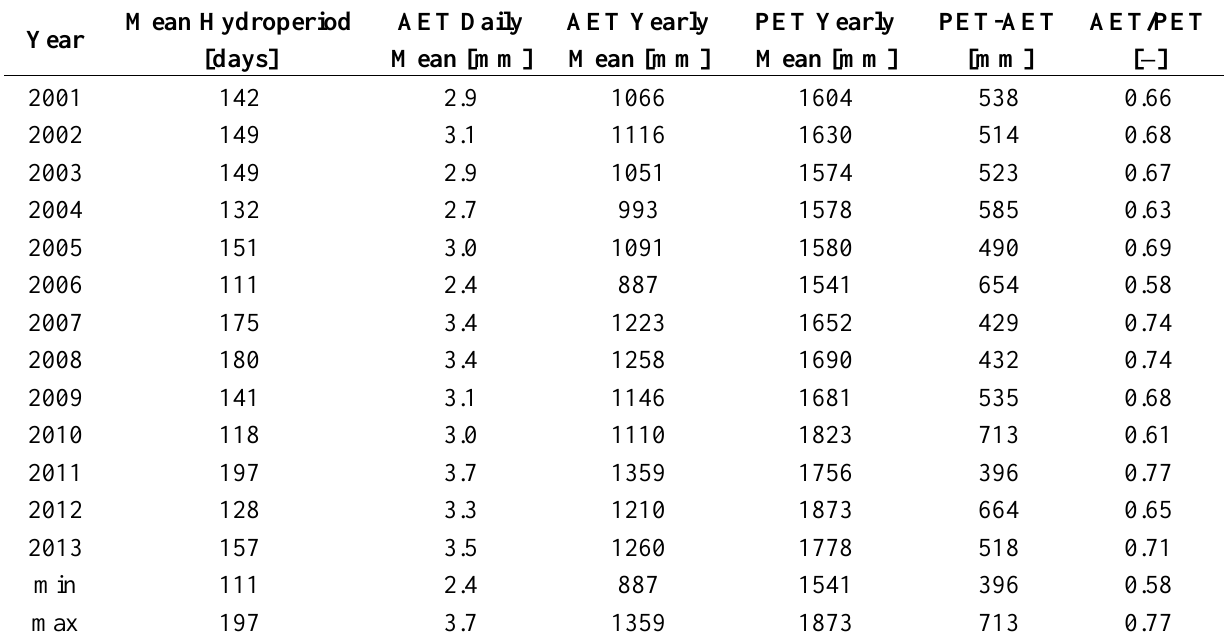
Table 5. Simulated mean hydroperiod, daily and yearly mean of actual evaporation (AET), yearly mean of potential evaporation (PET), the difference of yearly AET and PET as well as the ratio of AET and PET for the years 2001 to